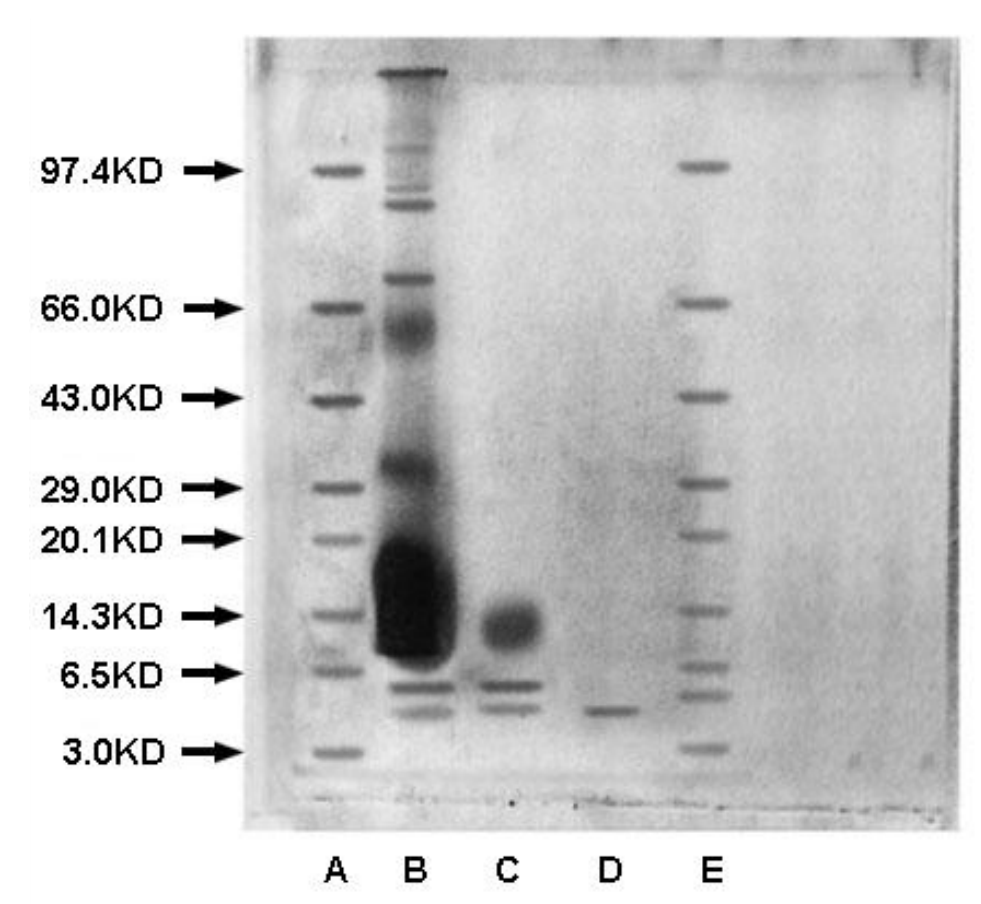
Figure 3: SDS-PAGE of the purified Palamneus gravimanus toxin. Lane A: molecular weight markers; Lane B: Palamneus gravimanus crude venom; Lane C: purified toxin after CM-Sephadex C-25 column; Lane D: purified toxin after Sephadex G-50; Lane E: molecular weight